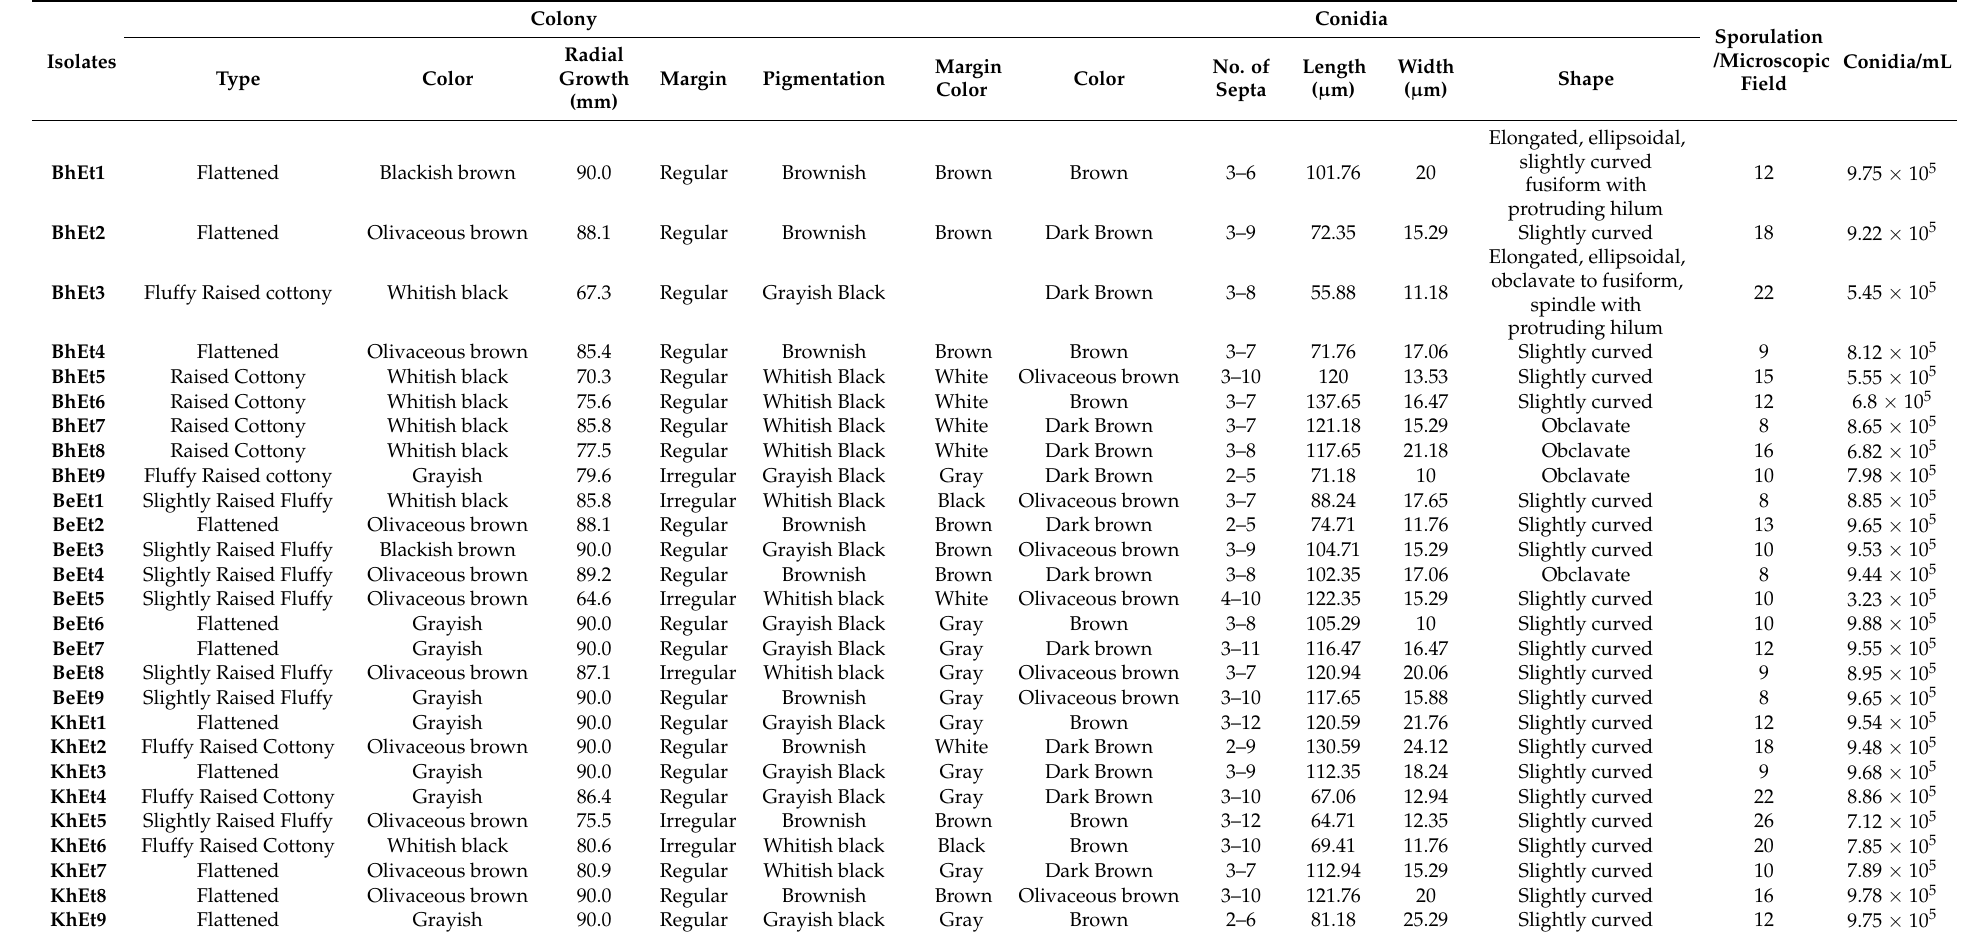
Table 1. Cultural and morphological variability among 45 isolates of E. turcicum causing NCLB disease of maize in